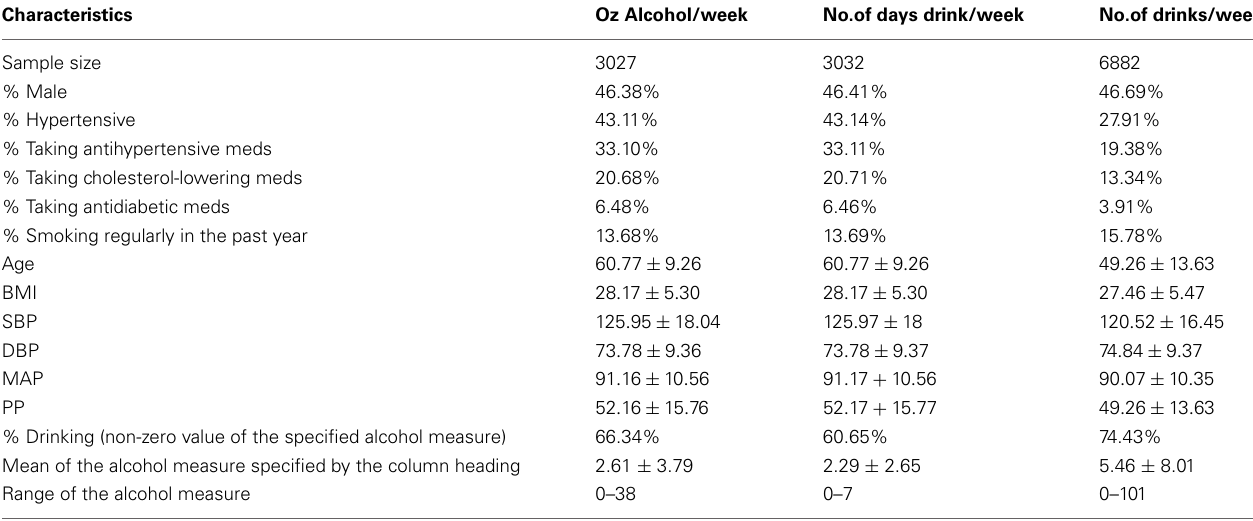
Table 1 | Descriptive statistics for the BP traits, covariates, comorbidities, and alcohol measures.